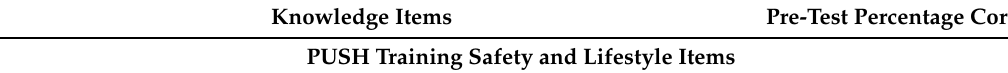
Table 1. Survey knowledge items and percentage correct at